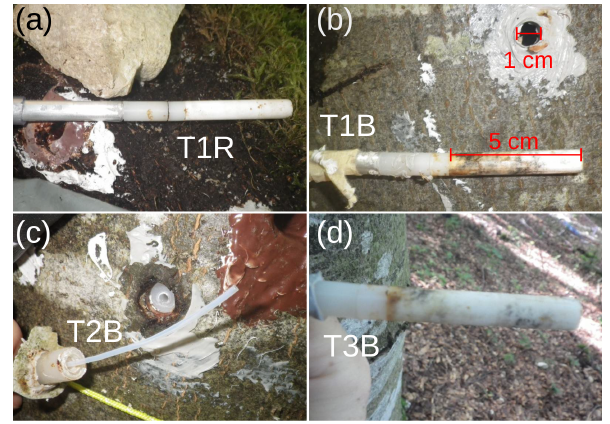
Figure A6. Freshly removed XWIPs 12 weeks after installation. The heads of XWIPs T1B (b) and T3B (d) were covered with biofilms, while the head of T1R (a) was as good as new. During re- moval, the probe head of T2B (c) broke off. Callus formation around the drill hole already